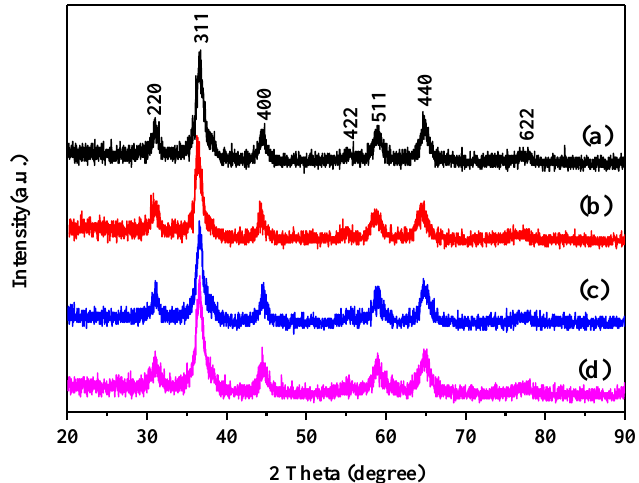
Figure 1. X-ray diffraction (XRD) patterns of the (a) MoO 3 -doped MnCo 2 O 4 (0), (b) MoO 3 -doped Figure 1. X-ray di ff raction (XRD) patterns of the ( a ) MoO 3 -doped MnCo 2 O 4 (0), ( b ) MoO 3 -doped MnCo 2 O 4 (0.04), ( c ) MoO 3 -doped MnCo 2 O 4 (0.10), and ( d ) MoO 3 -doped MnCo 2 O 4 MnCo 2 O 4 (0.04), (c) MoO 3 -doped MnCo 2 O 4 (0.10), and (d) MoO 3 -doped MnCo 2 O 4 (0.12).